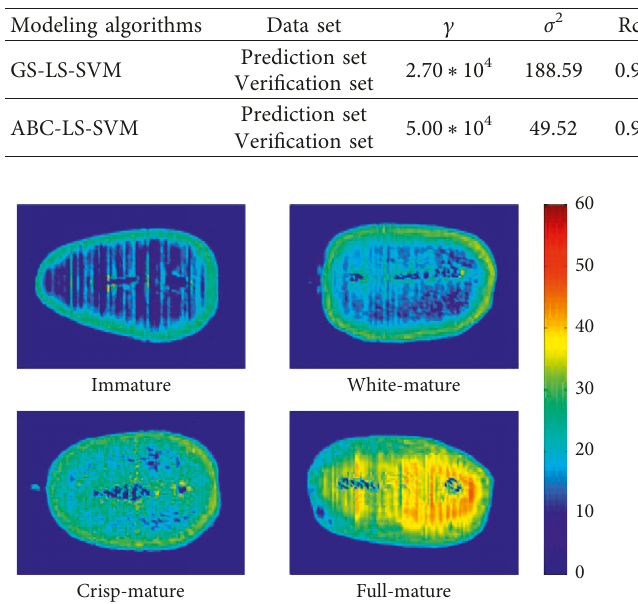
Figure 4: Examples of visualization in an SSC distribution map of the 4 maturity